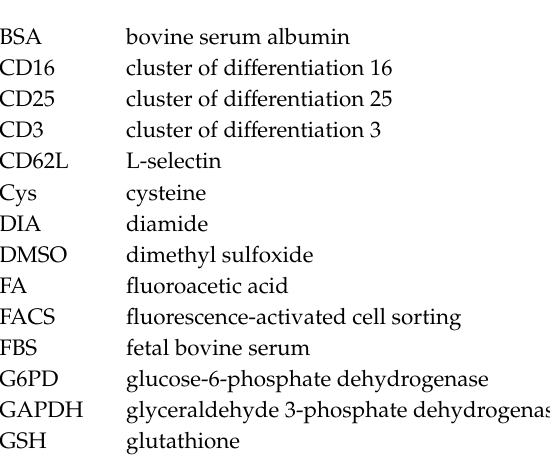
Figure S1: Detection by FACS of histone H2AX phosphorylation on Ser-139; Figure S2: Gating strategy; Figure S3: Expression of non-activated T cells CD25 receptor after treatment with diamide; Figure S4: CD25 and CD62L surface receptor expression of T cells treated with Syk inhibitors; Figure S5: TNF α , IL2, and IFN γ cytokines released by T